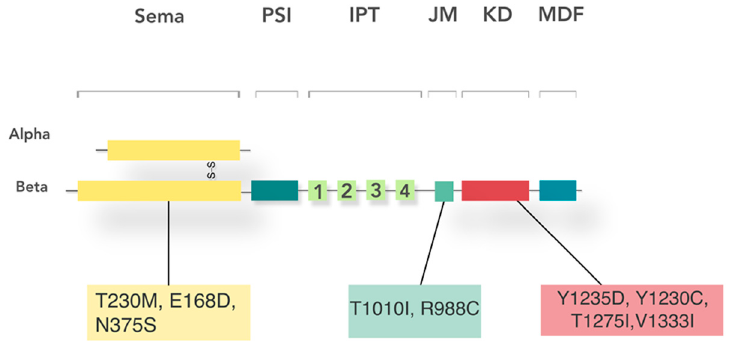
Figure 3. Common c-Met mutations in head and neck squamous cell carcinoma: T230M, E168D, and N375S affect the extracellular sema domain. Intracellularly, T1010I and R988C affect the juxtamedullary (JM) domain, while Y1235D, Y1230C, T1275I, and V1333I affect the kinase domain. PSI: plexin-semaphorin-integrin domain; IPT: immunoglobulin-plexin-transcription domain; KD: kinase domain; MDF: multifunctional docking site.